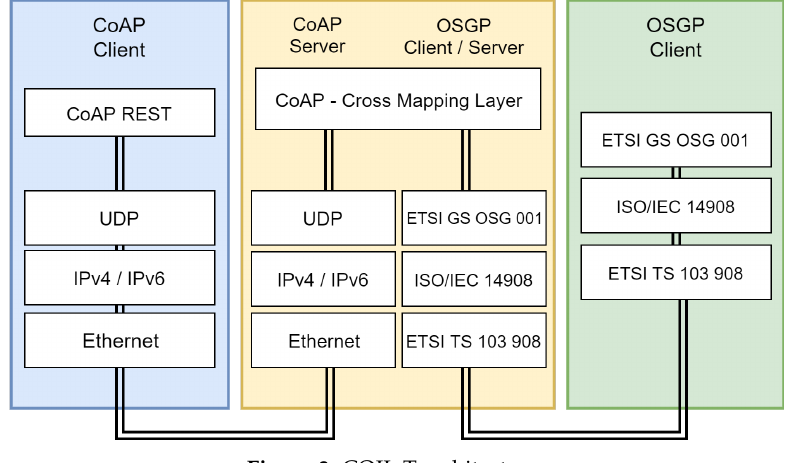
Figure 3. COIIoT architecture.